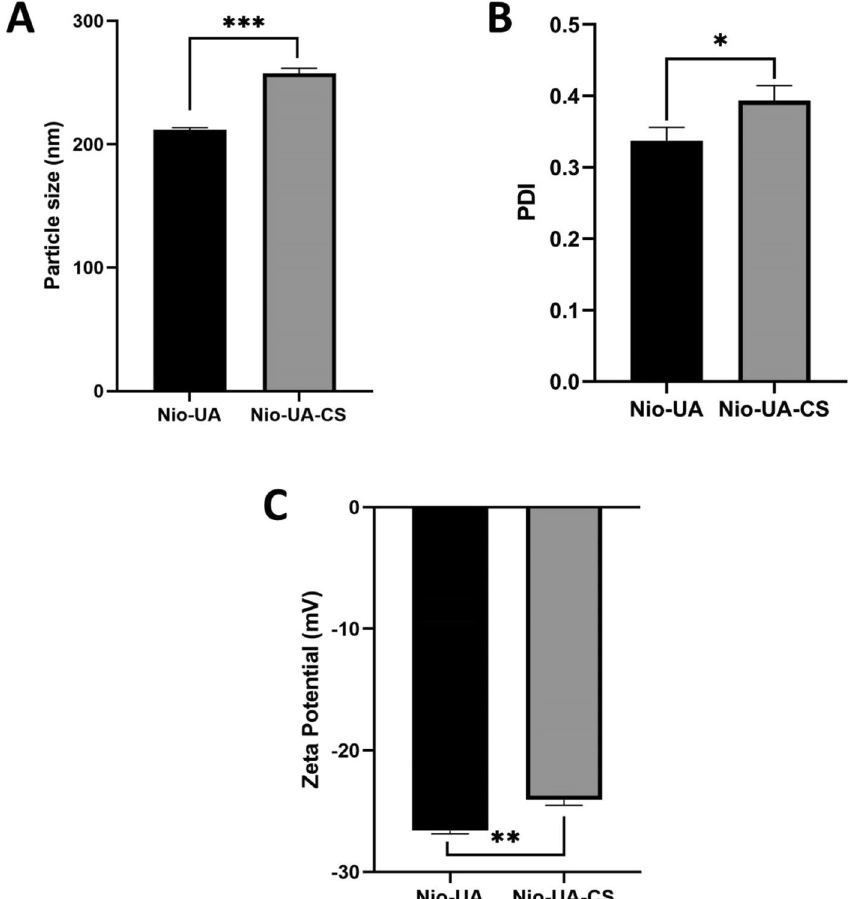
Figure 1. Average ( A ) particle size, ( B ) polydispersity index, ( C ) ζ -potential of Nio-UA and Nio-UA-CS. *p < 0.05; **p < 0.01; ***p <